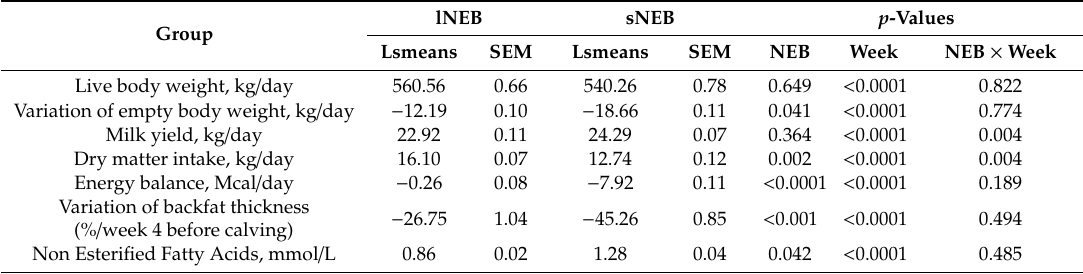
Figure 3. Energy balance ( A ) and plasma NEFA (non-esterified fatty acids) (mmol/l) ( B ) in Holstein cows with lNEB ( n = 6) or sNEB ( n = 7) at week 4 before calving and week 16 after calving. Results are presented as LSmeans ± SEM. Table 1. Management and nutritional parameters for the two groups of animals (severe Negative Energy Balance ( n = 7), and low Negative Energy Balance ( n = 6)). Results are presented as LSmeans. p -values of the e ff ects of NEB, week peripartum, interaction between Negative Energy Balance, and week